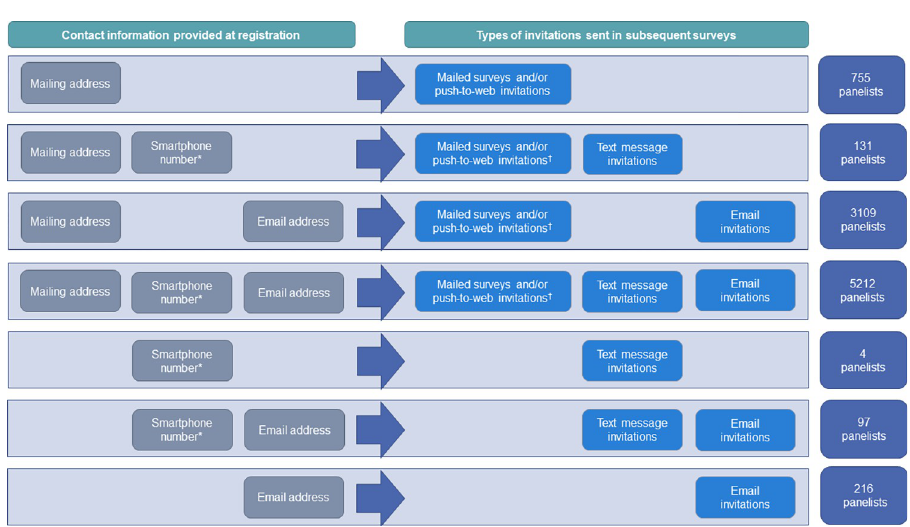
Fig 2. Types of contact information provided by panelists and types of invitations sent to panelists. The types of initial invitations and reminders that sampled panelists received for any given survey were determined by the types of contact information they provided when they registered for Healthy NYC. � Panelists who provided a cellphone number were asked if this was a smartphone that they could use to take surveys and were then asked to consent to receive text messages. † Due to budgetary and operational limitations, not all panelists who provided a mailing address received mailed paper surveys or push-to-web invitations if they provided any other contact information.